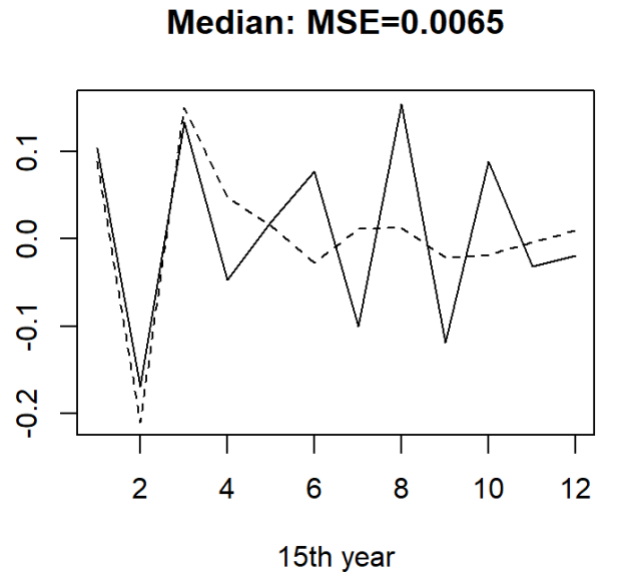
Figure 10. The curves of the true value (solid line) and FCQ model (dotted line) with MSE =